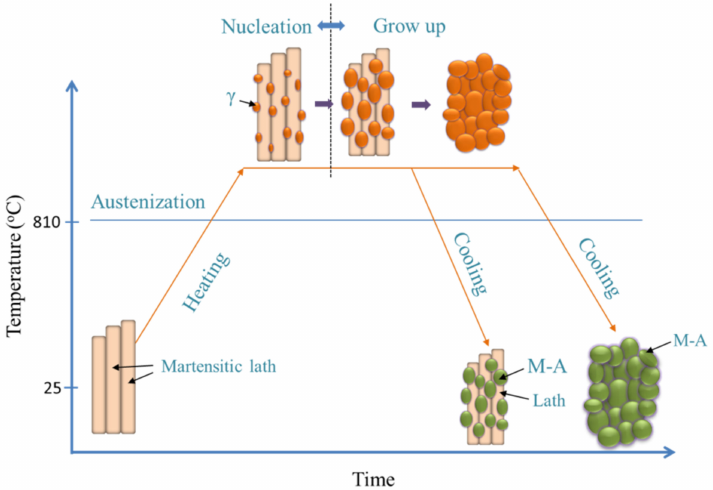
Figure 14. Schematic illustration of the microstructure evolution